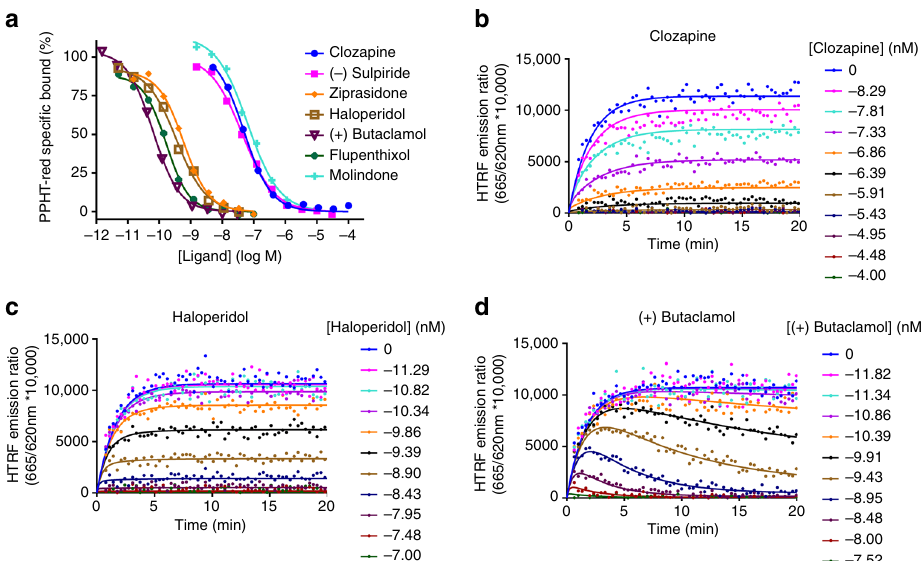
Fig. 2 Equilibrium and competition association binding. a Competition between PPHT-red (12.5 nM) and increasing concentrations of representative atypical and typical APDs clozapine, ( − )sulpride, ziprasidone, haloperidol, (+)butaclamol, fl uphenthixol, and molindone at the human dopamine D 2 R. PPHT- red competition association curves in the presence of b clozapine, c haloperidol, and d (+)butaclamol. All binding reactions were performed in the presence of GppNHp (100 μ M) with nonspeci fi c-binding levels determined by inclusion of haloperidol (10 μ M). Kinetic and equilibrium data were fi tted to the equations described in “ Methods ” section to calculate K i , K d , and k on and k off values for the unlabeled ligands; these are summarized in Table 1. Data are presented as singlet values from a representative of four. All data used in these plots are detailed in Table